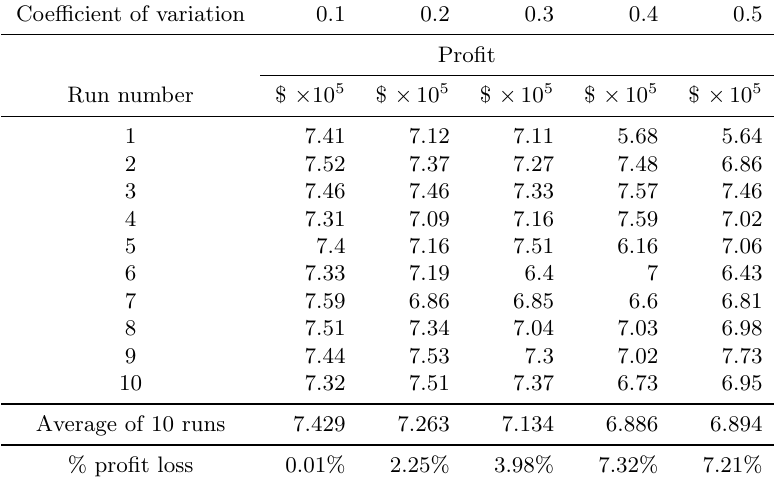
Table 6: Effect of variability of catch on